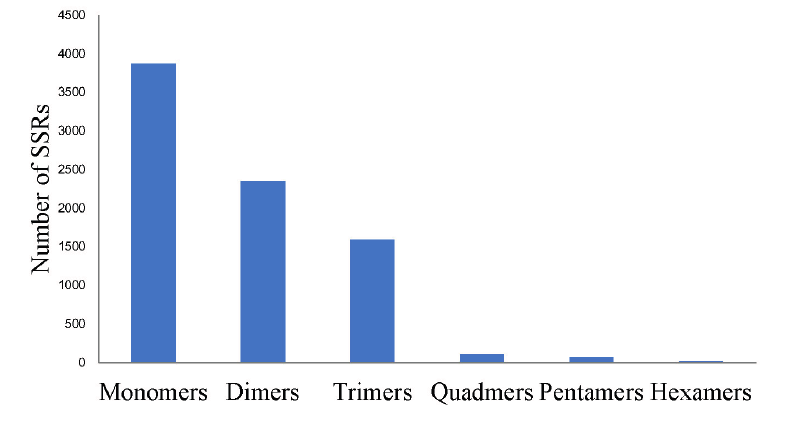
Figure 7. Summary of simple sequence repeat (SSR) identified from the sea cucumber coelomocytes transcriptome.